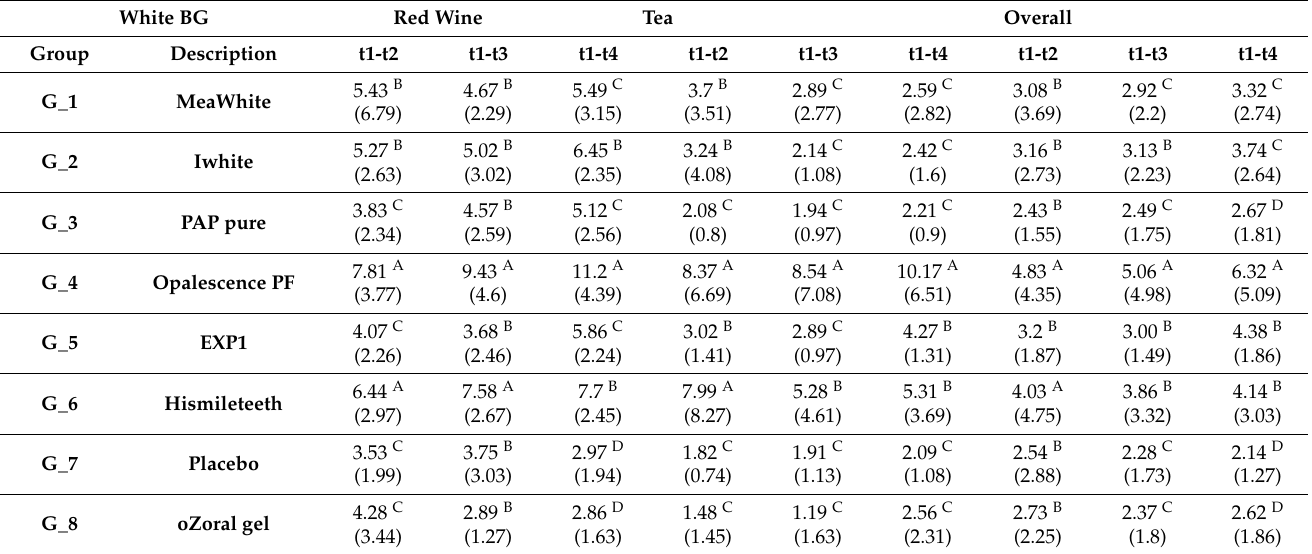
Table 5. Average CIEDE00 color changes over time and standard deviations (in parentheses) per group analyzed over a black background and corresponding grouping (A, best; D, worst).